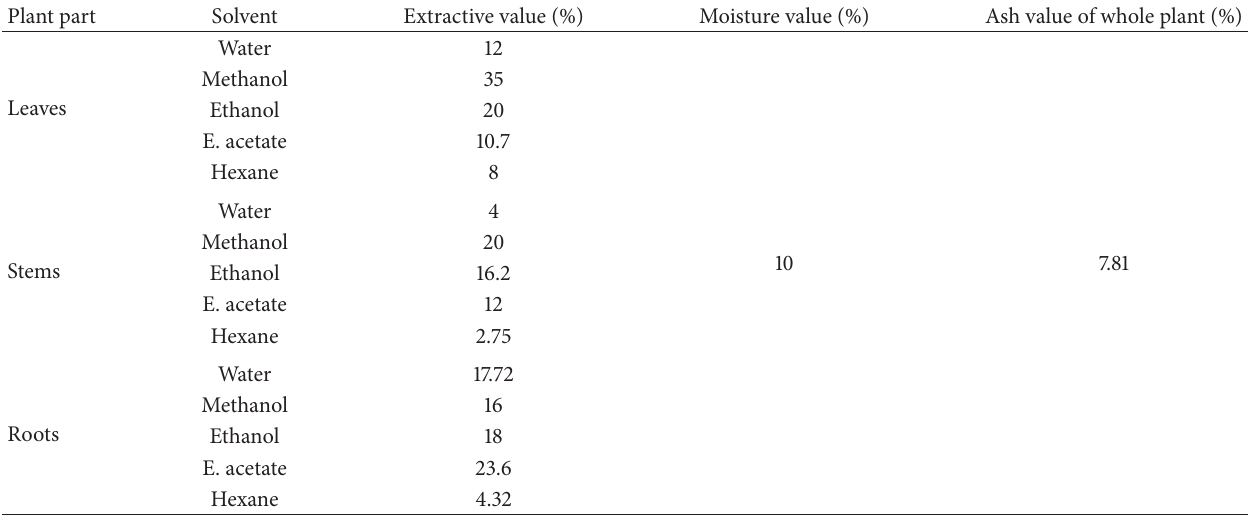
Table 1: Ash, moisture, and extractive values of fifteen extracts of Adiantum capillus veneris